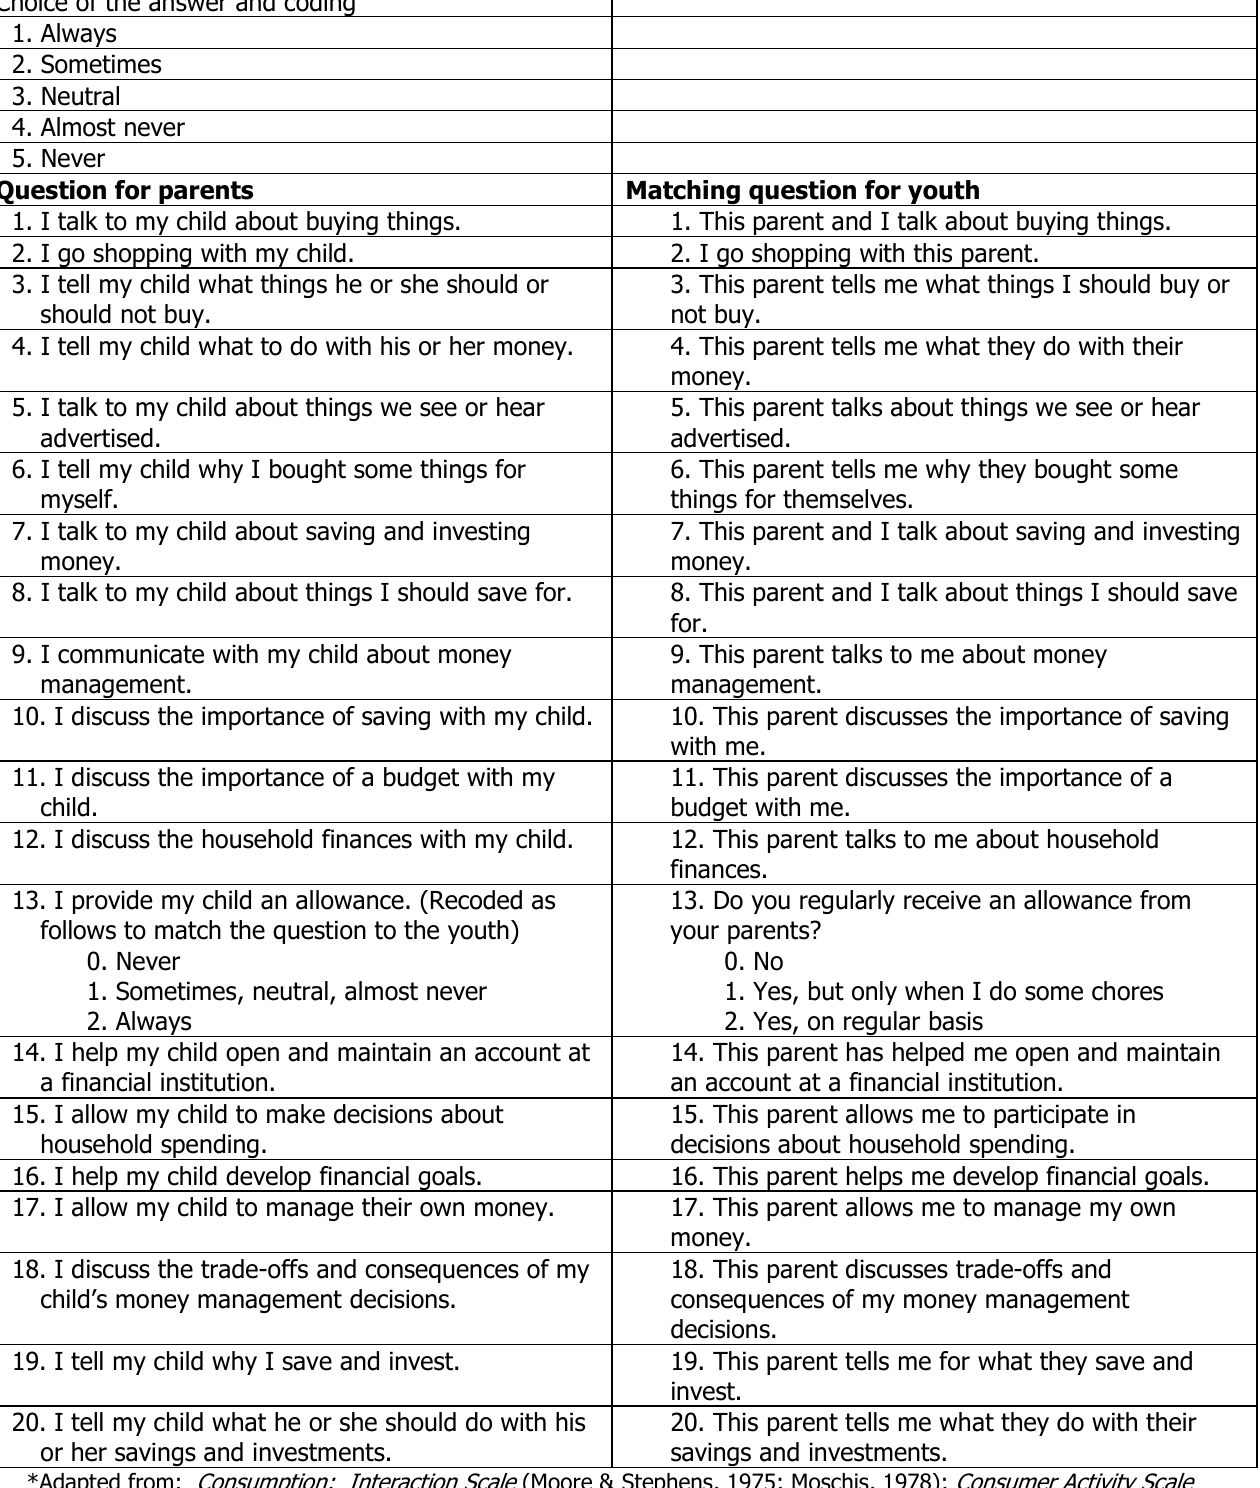
Communication on Money*: Matched Survey Items for Parent-Youth